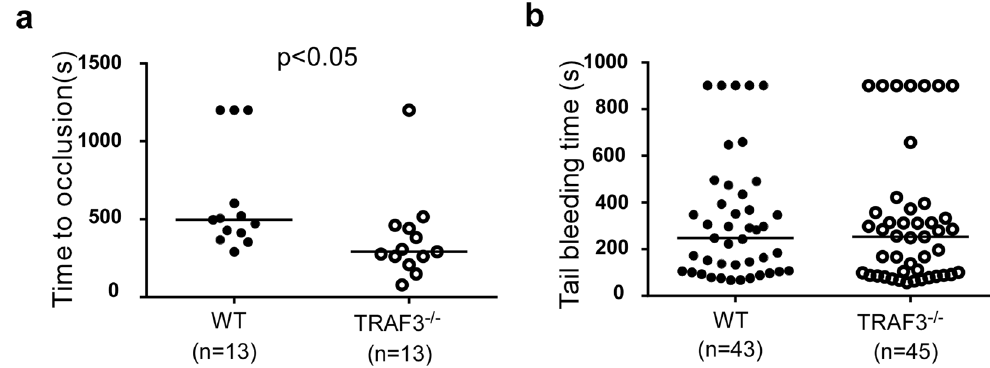
Figure 6. TRAF3 knockout potentiated thrombosis but did not affect hemostasis. ( a ) FeCl 3 -induced carotid artery injury was performed and time to occlusive thrombosis recorded as described under Experimental Procedures . The occlusion time of each mouse is shown as circles. The bars represent the median occlusion time (282.5 s for TRAF3 − / − , and 483.5 s for TRAF3 + / + , n = 13 for each group). The difference in occlusion time between TRAF3 + / + and TRAF3 − / − mice is statistically significant (p = 0.010 by Nonparametric Mann- Whitney test). ( b ) Bleeding time tests were performed blind to genotype in TRAF3 + / + (8–10 weeks old, n = 43) and TRAF3 − / − littermates (n = 45) generated from mating TRAF3 + / − mice. The solid triangles represent the bleeding time of a single mouse. The bars represent the median bleeding time of the group (251.0 s for TRAF3 − / − , and 245.5 s for TRAF3 + / + ). The difference in bleeding time between TRAF3 + / + and TRAF3 − / − mice is not statistically significant (p > 0.1 by Nonparametric Mann-Whitney